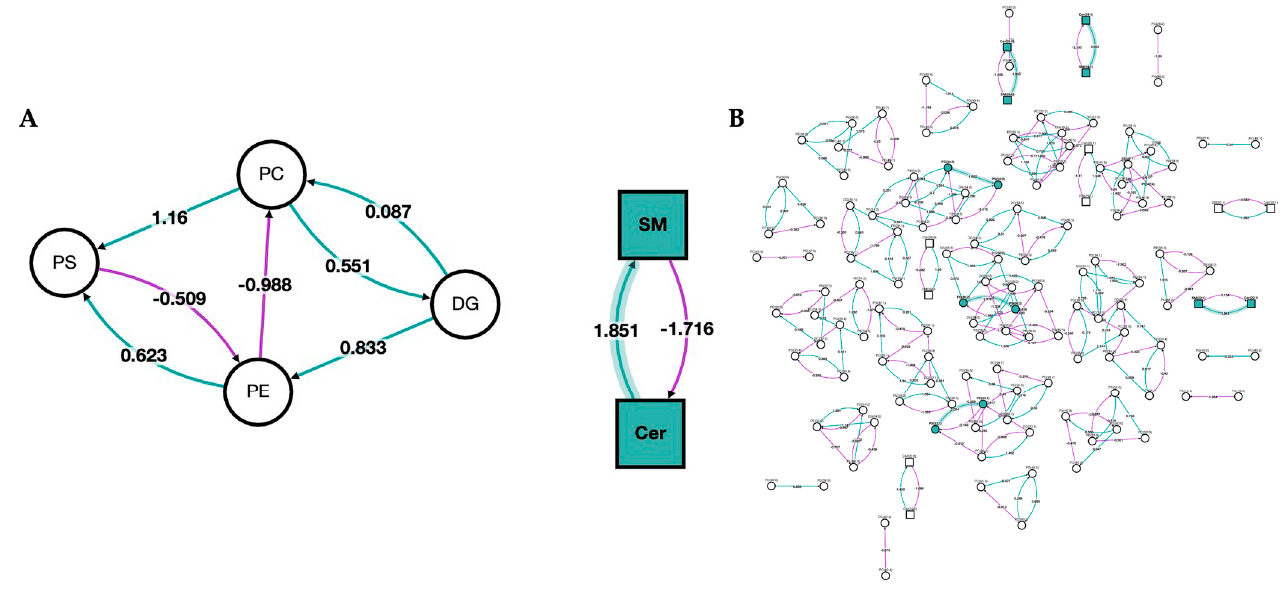
Figure 5. Network of lipid classes and species changed in bilirubin nanoparticles and vehicle- treated obese mice. Network analysis of PEG-BR vs. VEH-treated mouse livers. ( A ) Network analysis of the lipid class; and ( B ) network analysis of the lipid species. Node shape denotes the lipid type, with circles representing glycerolipids and glycerophospholipids and squares representing sphingolipids. The node color represents whether the lipid class or species was changed by the PEG-BR (green) or remain unchanged (white). The purple line denotes a negative z-score, and the green line indicates a positive z-score. The shaded line indicates that the z-score is implied in a lipid class or species that was changed by PEG-BR.